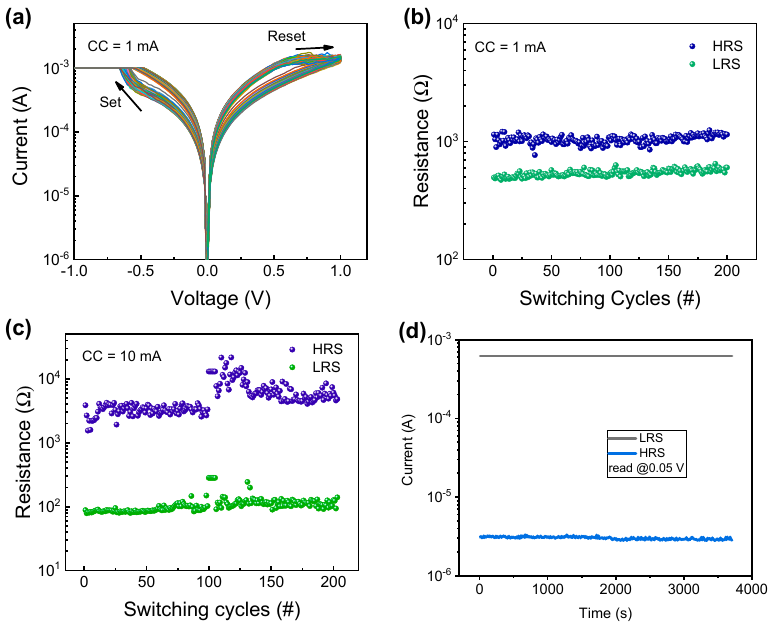
Figure 2. ( a ) I–V characteristics of the Pt/TiO 2 /HfAlO x /TiN RRAM device. ( b ) Endurance at a compliance current (CC) of 1 mA in the high-resistance state (HRS) and low-resistance state (LRS). ( c ) Endurance at a CC of 10 mA. ( d ) Retention characteristics for 3600 s.